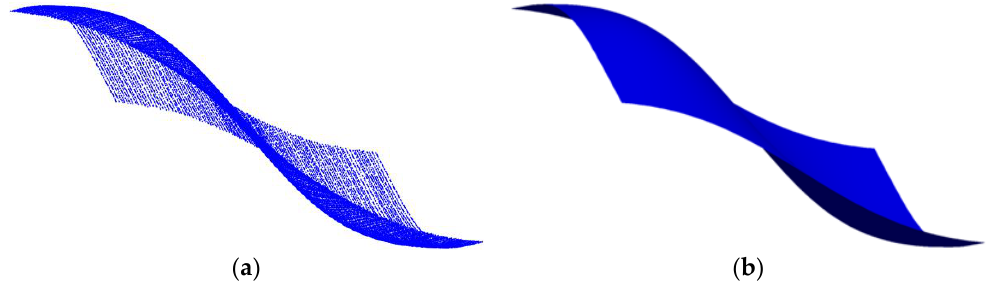
Figure 6. Surface fitting of a quadric surface: ( a ) the data points chosen randomly from grid data; ( b ) the fitting surface.